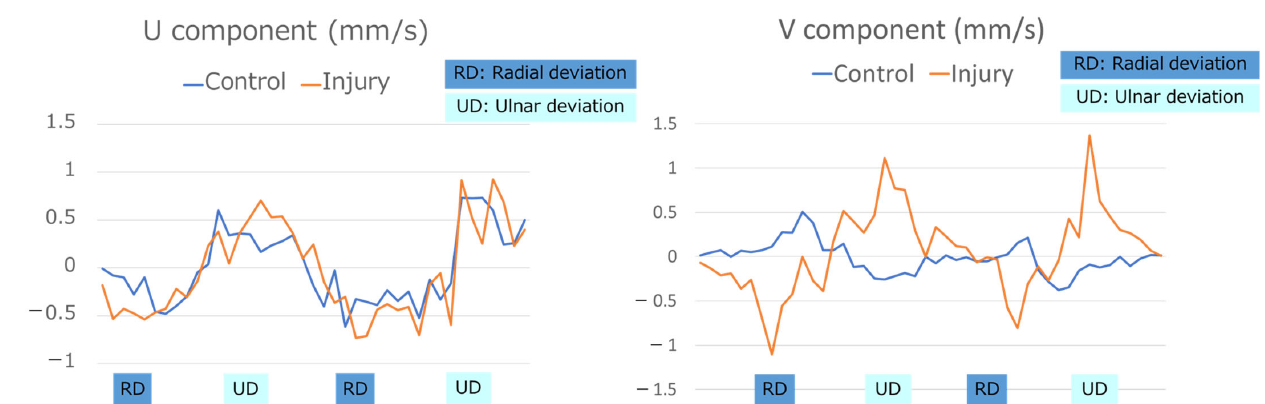
Figure 6. Analysis of the V and U components in the groups. The V component values revealed that the tendon moved toward the deep side during ulnar deviation (UD) and toward the superficial side during radial deviation (RD) in the injury group, while opposite findings and smaller values were seen in the control group. The U component did not reveal any differences between the two groups.